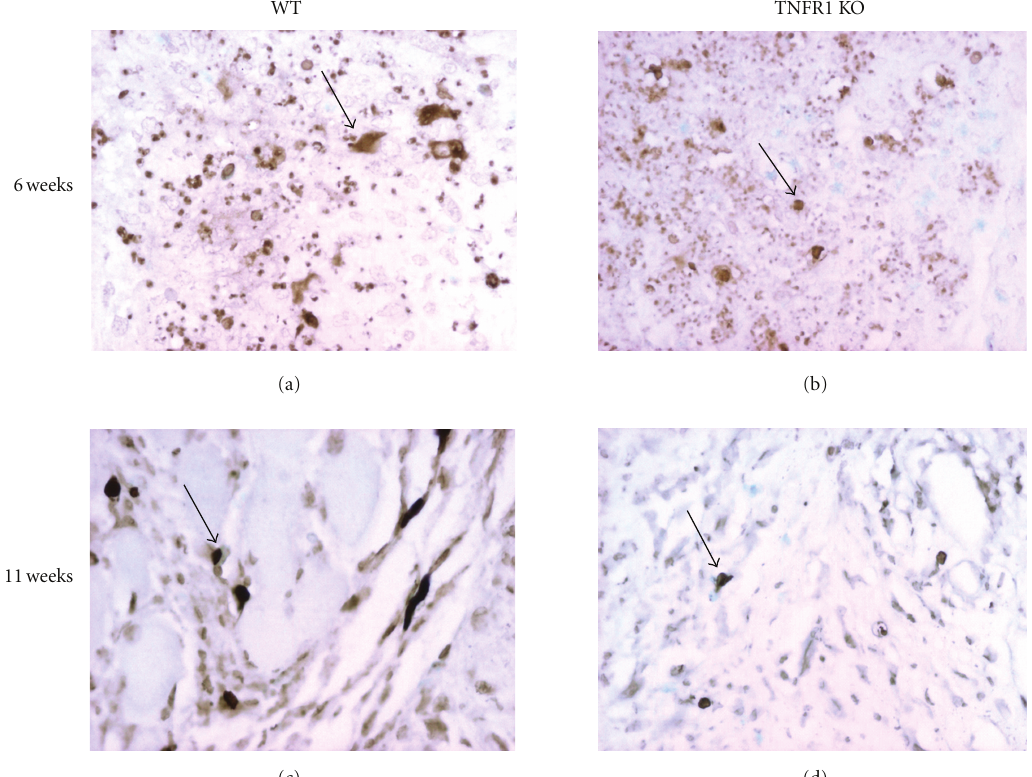
Figure 5: Apoptosis in lesions from WT and TNFR1 KO mice infected by L. major . Mice were infected with L. major in the footpad (1 × 10 6 ) and after 6 weeks (a and b) and 11 weeks (c and d) of infection. Tissues were stained by TUNEL, as described in Section 2. Arrows indicate TUNEL positive